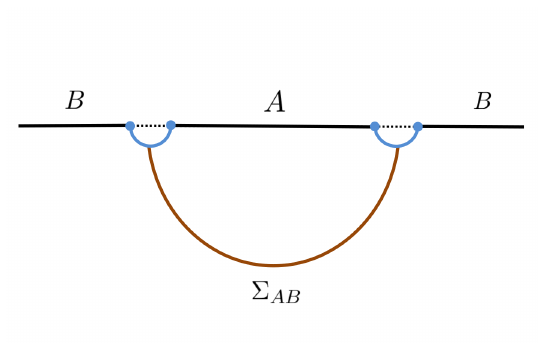
Figure 3: The boundary field theory is in a pure state and the complement of A ∪ B is infinitesimal. The blue lines consist of the RT surface E is the minimal cross section of the entanglement wedge W